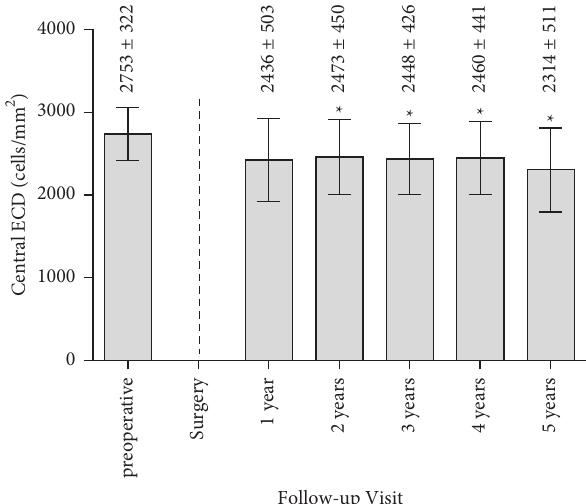
Figure 3: Individual ECD pre- and up to 5 years postoperative. Values are presented as mean ± SD ( ∗ p < 0 . 01).